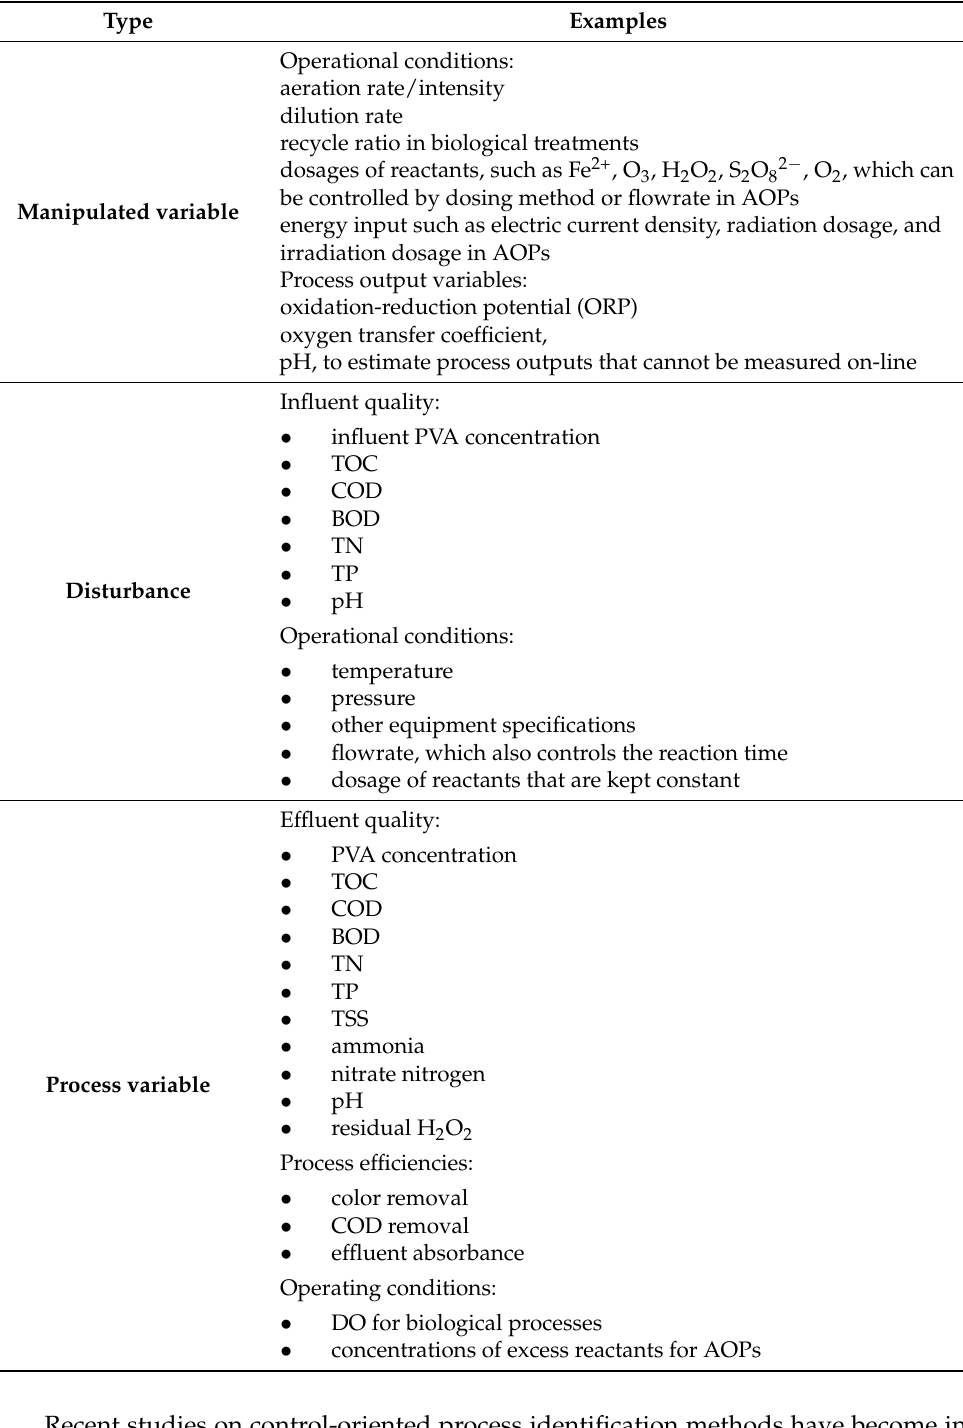
Table 3. List of Manipulated variables, disturbances, and process variables in the PVA degradation